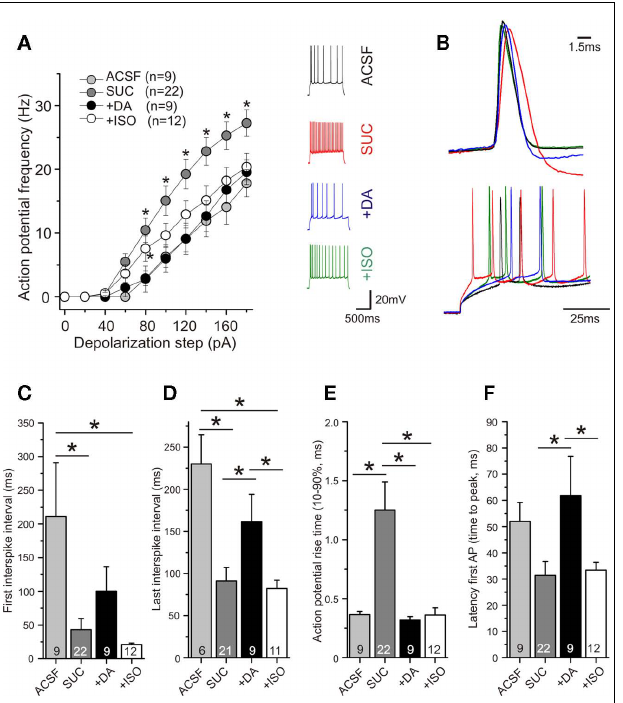
FIGURE 7 |Acute application of dopamine, but not isoproterenol, completely restores firing pattern in sucrose prepared slices. Experimental conditions as in Figure 5 . APs were recorded in current clamp in the absence/presence of dopamine (DA) or isoproterenol (ISO). (A) After 6–10min application of DA (20 μ M), or 10 μ M ISO the AP frequency of neurons in sucrose prepared slices was either completely (DA) or partially (ISO) decreased, back to levels observed in ACSF prepared slices (* p < 0.05).Typical original traces are shown as insets. (B) Representative original traces for rise times and latency changes in response to 120pA current injection. First and last interspike intervals were prolonged after acute application of DA (but not ISO) to a comparable level as observed in ACSF prepared slices [ (C,D) , * p < 0.05].The prolonged rise times typical for neurons after sucrose preparation were reduced by acute application of DA or ISO [ (E) , ** p < 0.01]. (F) The first AP was generated significantly later after application of DA compared to sucrose preparation. ISO had no effect on spike latency. All measurements were performed with APs induced by